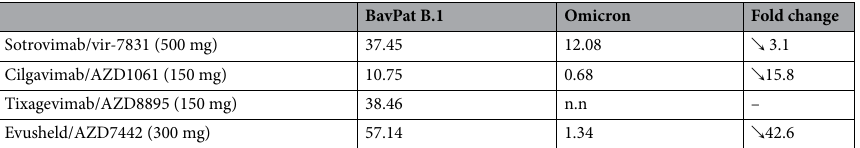
Table 2. Neutralizing capacity of Sotrovimab, Cilgavimab and Evusheld. Values are expressed in millions of neutralizing units (MNU 50 ) per treatment. One unit is defined as the amount of a given antibody needed to neutralize 50% of 100 TCID 50 of a given strain. Doses refer to treatments authorized in the European Union (Sotrovimab: 500 mg IV for the early treatment of infected patients 31 ; Evusheld: 300 mg IM (corresponding to Cilgavimab 150 mg + Tixagevimab 150 mg) for prophylaxis of infection in patients with important risk